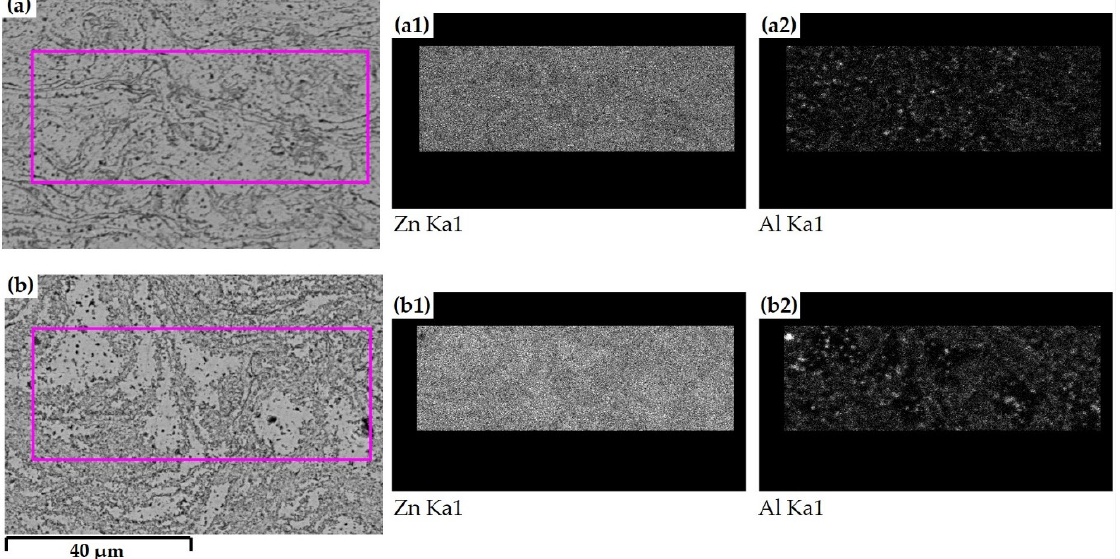
Figure 8. EDX analyses showing smart-maps of the element distribution of Zn and Al for ( a ) com- pressed air sprayed coating, ( a1 ) Zn distribution and ( a2 ) Al distribution; ( b ) argon sprayed coating, ( b1 ) Zn distribution, and ( b2 ) Zinc distribution.